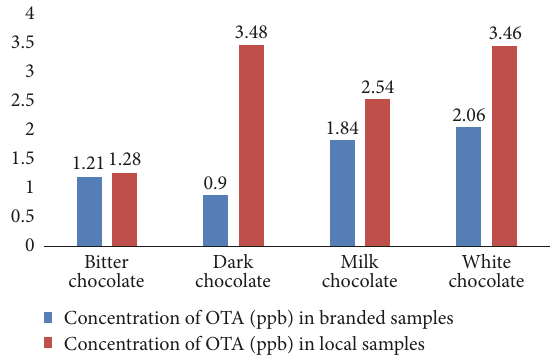
Figure 7: Concentration of OTA in branded and local samples of